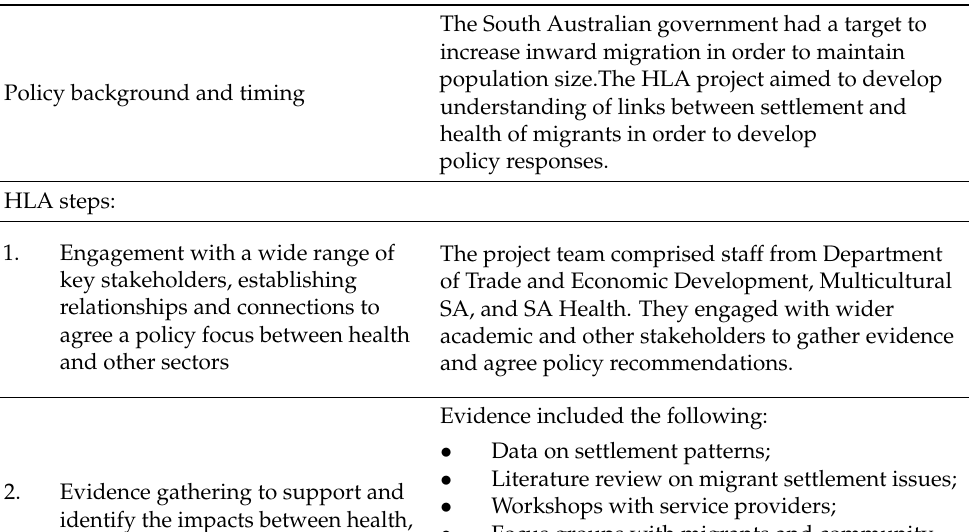
Table 2. HLA of regional migrant settlement in South Australia [53].